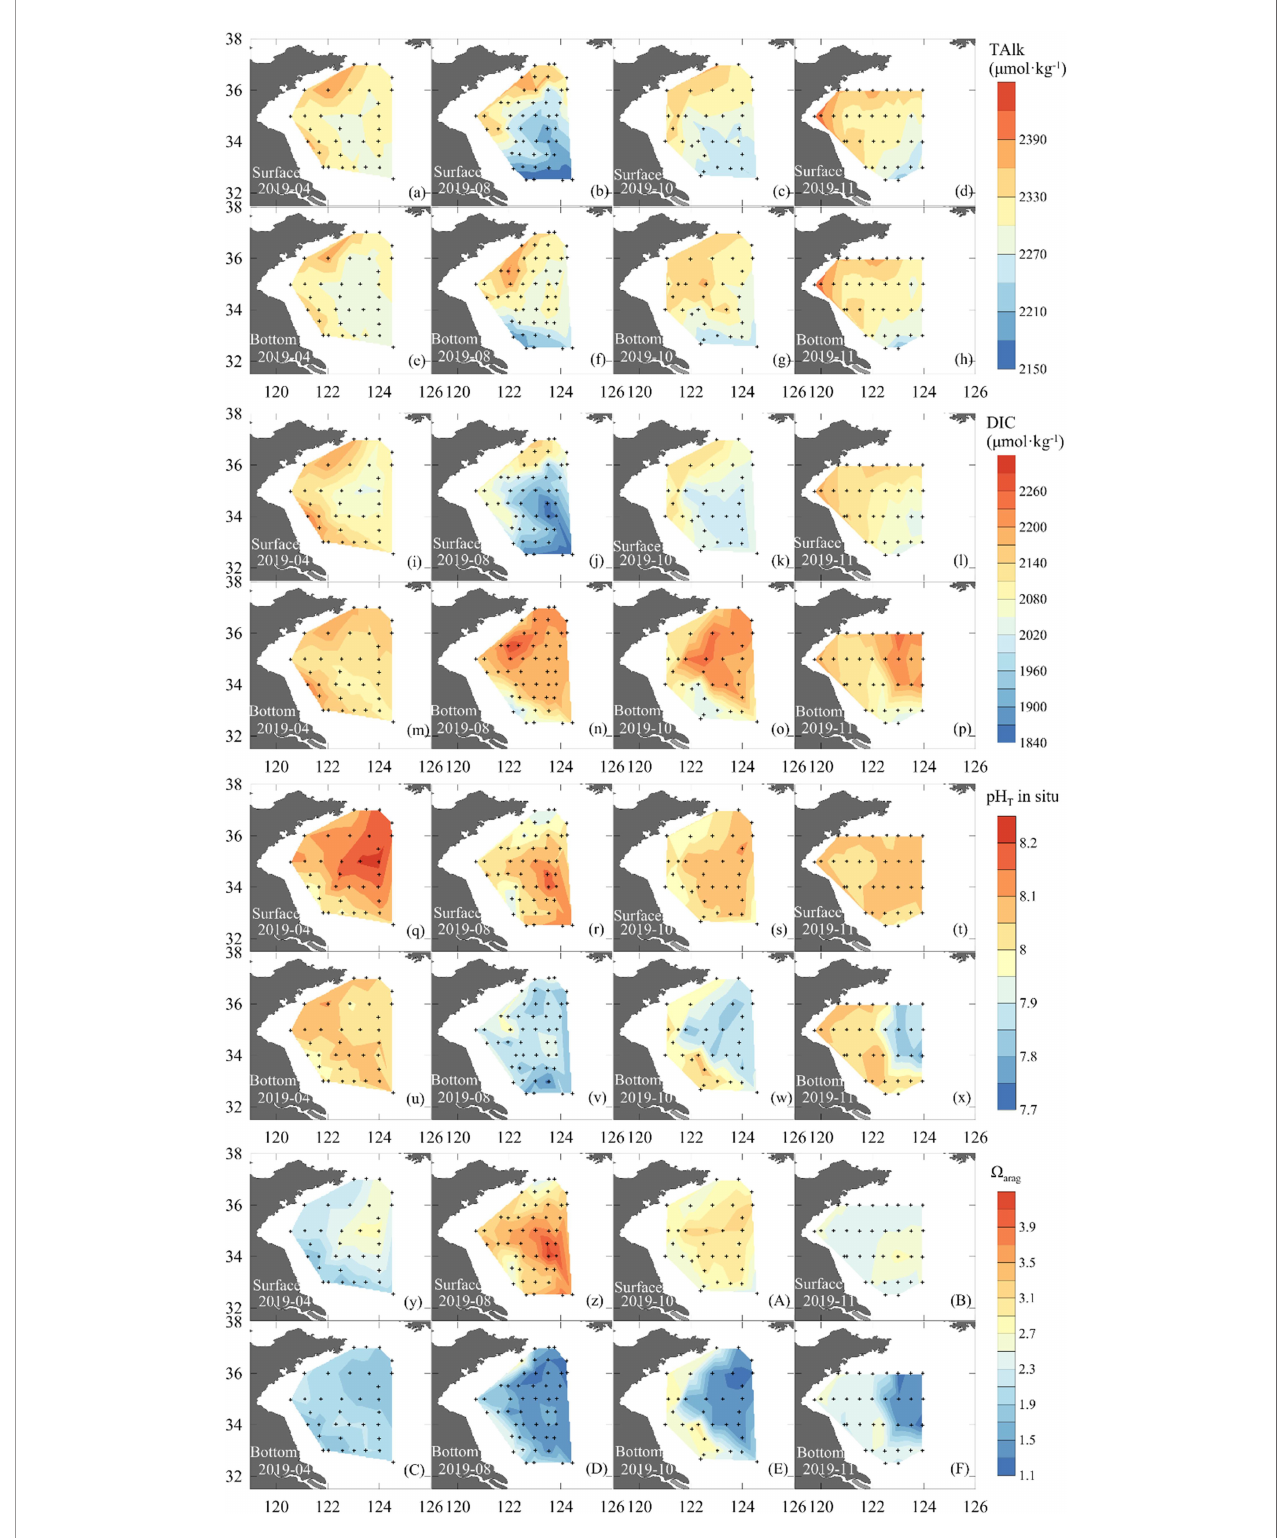
FIGURE 4 | Surface and bottom-water distribution of TAlk (a-h) , DIC (i-p) , pH T (q-x) , and aragonite saturation state ( W arag ) (y-z, A-F) during seasonal mapping cruises carried out in 2019.